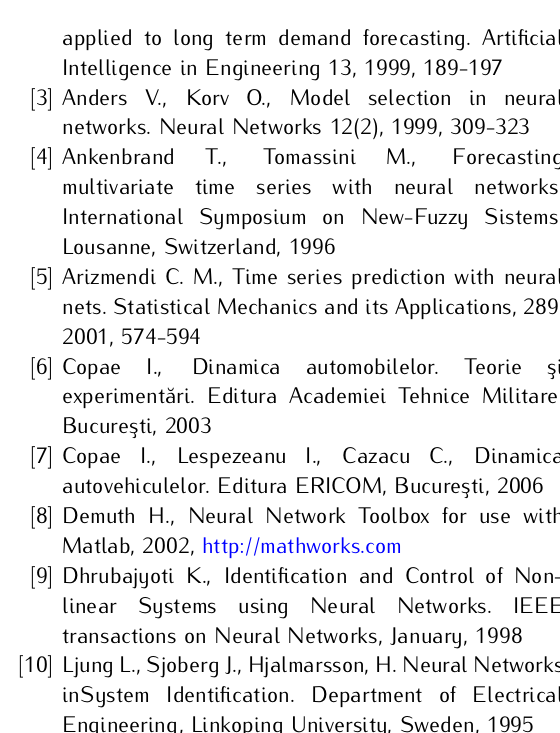
Figure 11. Block chart of neuronal